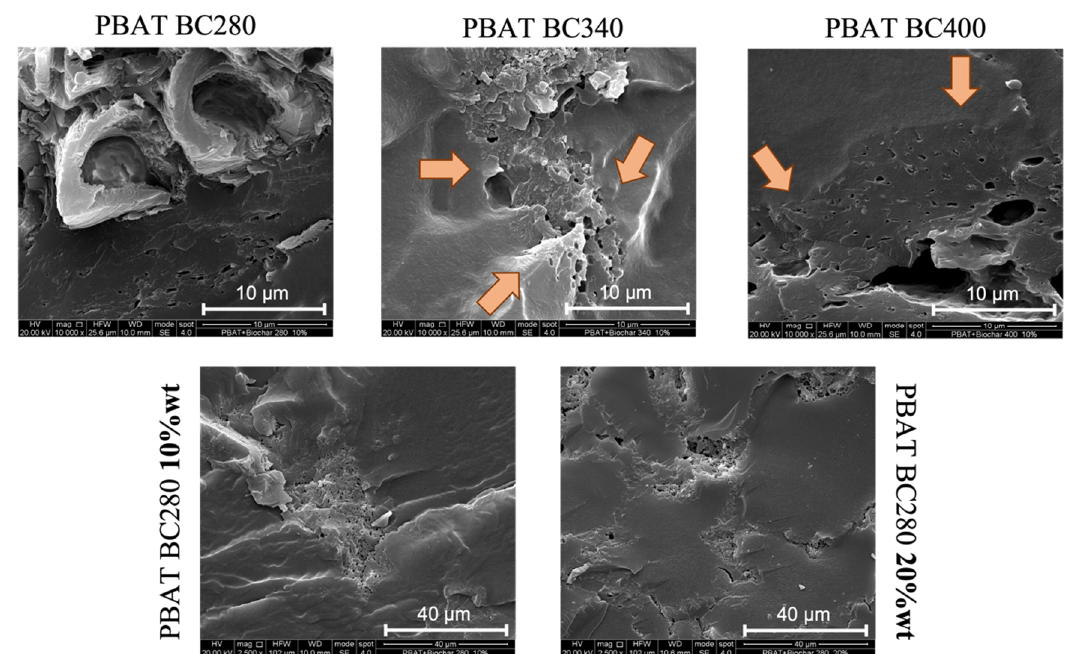
Figure 5. SEM micrographs of biocomposites varying pyrolysis temperature of biochar (top) and varying biochar concentration (down).